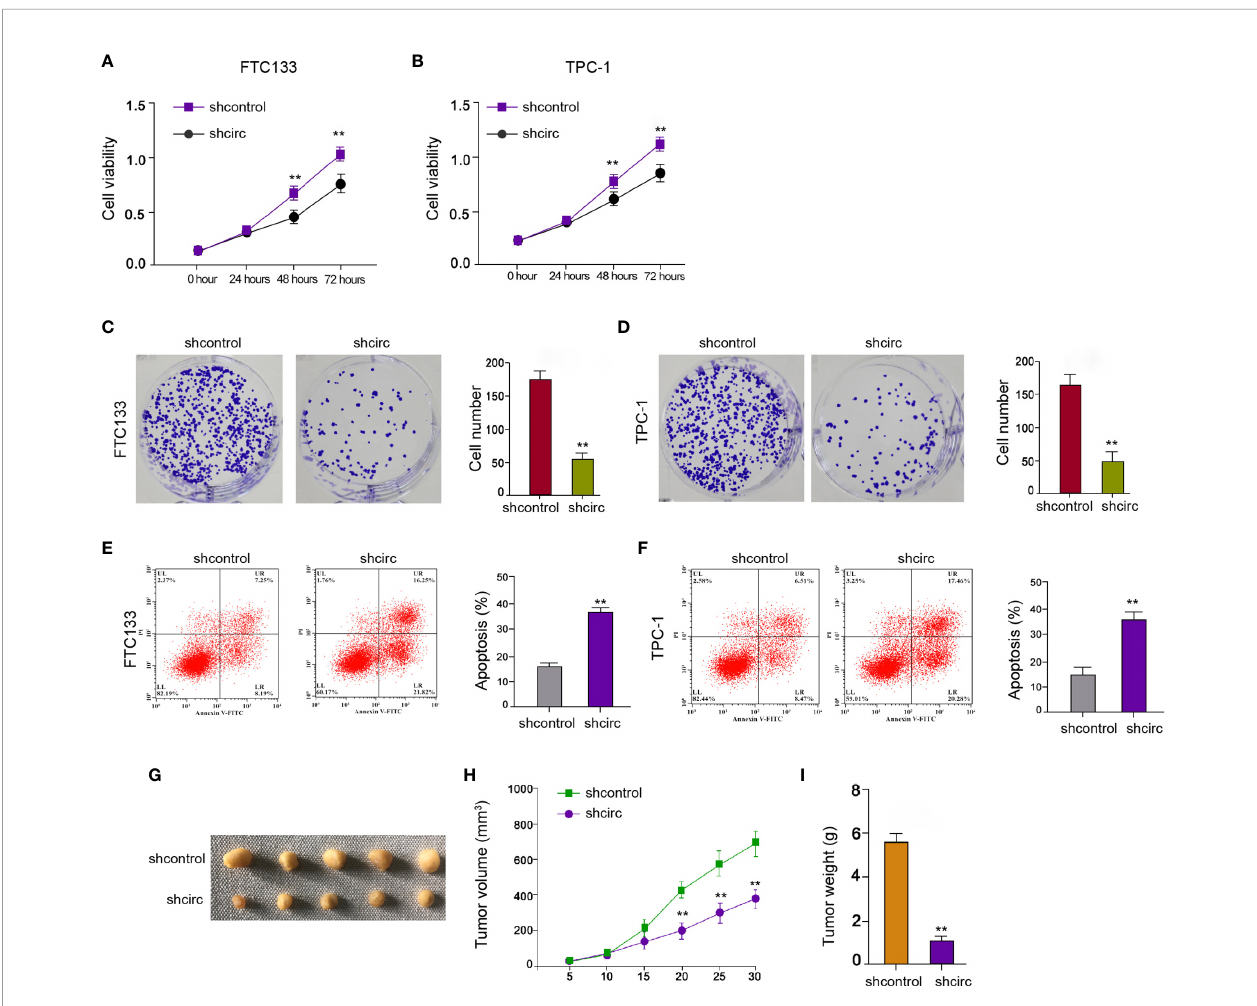
FIGURE 2 | Circ_0067934 contributes to cell proliferation of thyroid cancer. (A, B) The analysis of FTC133 and TPC-1 cell viability by MTT assays. (C, D) Detection of cell proliferation of FTC133 and TPC-1 cells by colony formation assays. (E, F) Apoptosis analysis of FTC133 and TPC-1 cells by fl ow cytometry. (G – I) Tumor growth in nude mice by tumorigenicity assays. FTC133 cells were transfected with control shRNA or circ_0067934 shRNA and were subcutaneously injected into the left fat pad of mice. After 5 days of injection, we measured tumor growth every 5 days. We sacri fi ced the mice after 30 days of injection. The tumor size (G) , tumor volume (H) , and tumor weight (I) were demonstrated. mean ± SD, ** P <